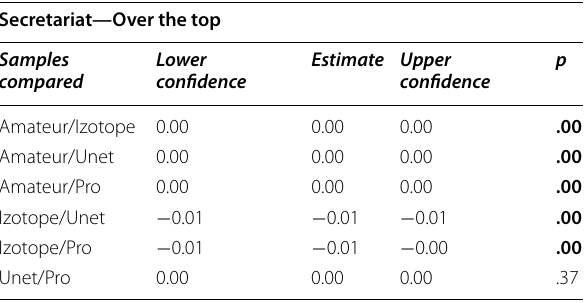
Table 3 Statistical significance analysis results of the harmonic energy descriptor for the “Secretariat—Over the top” song Secretariat—Over the top Samples Lower Estimate Upper p compared confidence confidence Amateur/Izotope 0.00 0.00 0.00 .00